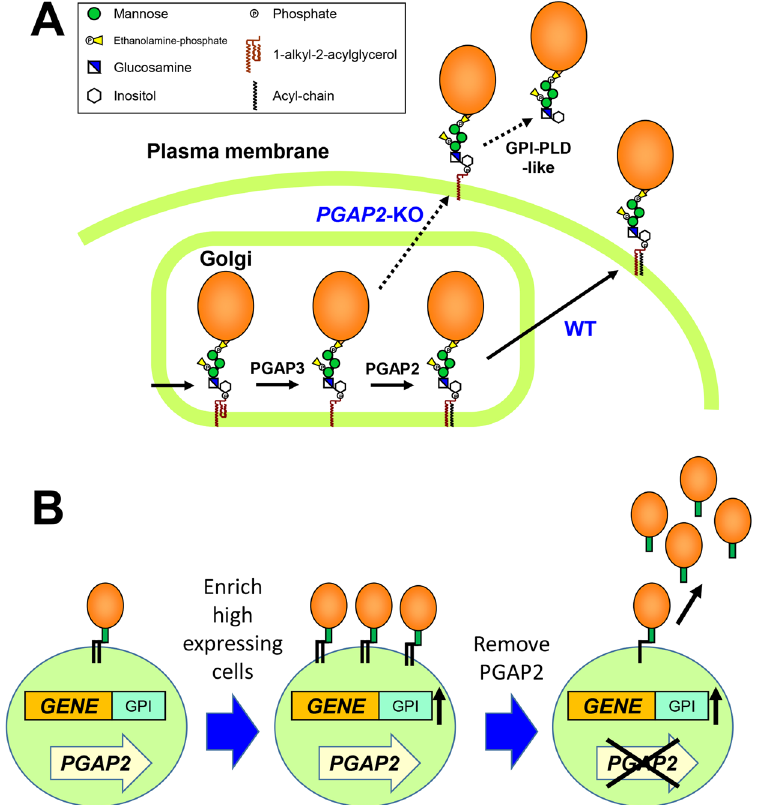
Figure 1. GPI-based protein production system. ( A ) PGAP2 is required for the addition of the saturated acyl chain to the lyso-GPI moiety, which ensures correct expression of GPI-APs on the cell surface. In PGAP2 mutant cells, lyso-GPI-APs are transported to the cell surface and then most of the GPI-APs are secreted into the medium. Since lyso-forms of GPI-APs are very sensitive to PLD, the GPI structure of secreted proteins become PLD-cleaved forms. ( B ) The GPI-anchoring system ensures the expression of target proteins as GPI- APs on the cell surface. Cells expressing target proteins at a high level can be enriched by selection of the GPI- anchored target proteins. Removal of the PGAP2 gene results in higher amounts of the target proteins being secreted into the